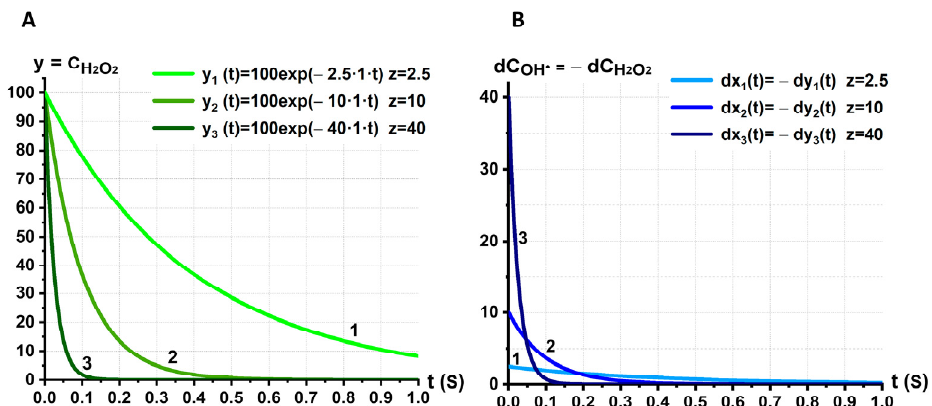
Figure 5. Kinetics of ROS reduction in the RBC system over time for different concentrations z = 2.5, z = 10, z = 40. ( A ) The dependence C H